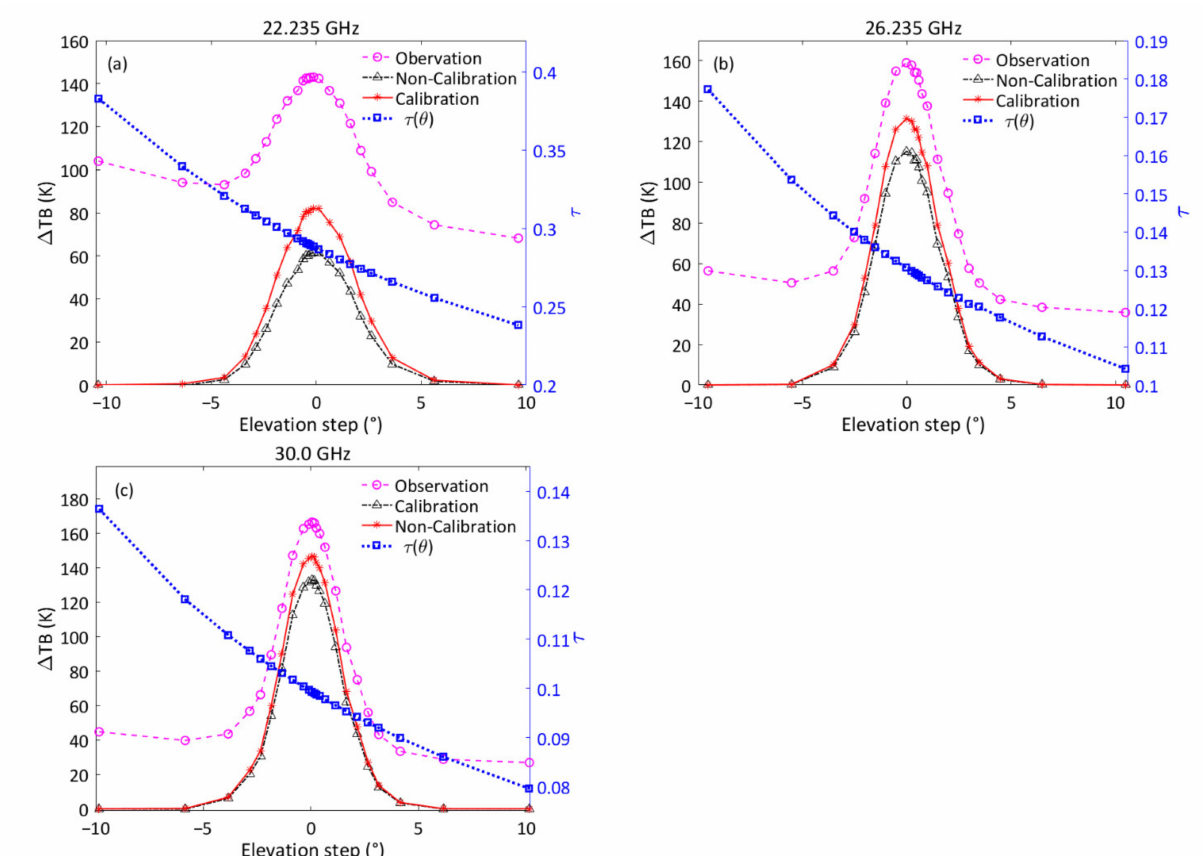
Figure 4. An example of the solar azimuth scanning observation on 18 June 2020, 17:10 p.m. (local time). The pink dashed line is the scanning point values. The red solid line is the TB increment after the atmospheric attenuation calibration and the black dash-dotted line is for the observational TB increments without the atmospheric attenuation calibration. The blue dotted line is the atmospheric attenuations at different elevations. The markers represent the observed data and the origin represents the center of the sun. The left axis is the solar TB increment ( ∆ TB) at different elevations and the right axis is the atmospheric opacity ( τ ) at different elevations. ( a ) 22.235 GHz, ( b ) 26.235 GHz, and ( c ) 30.0